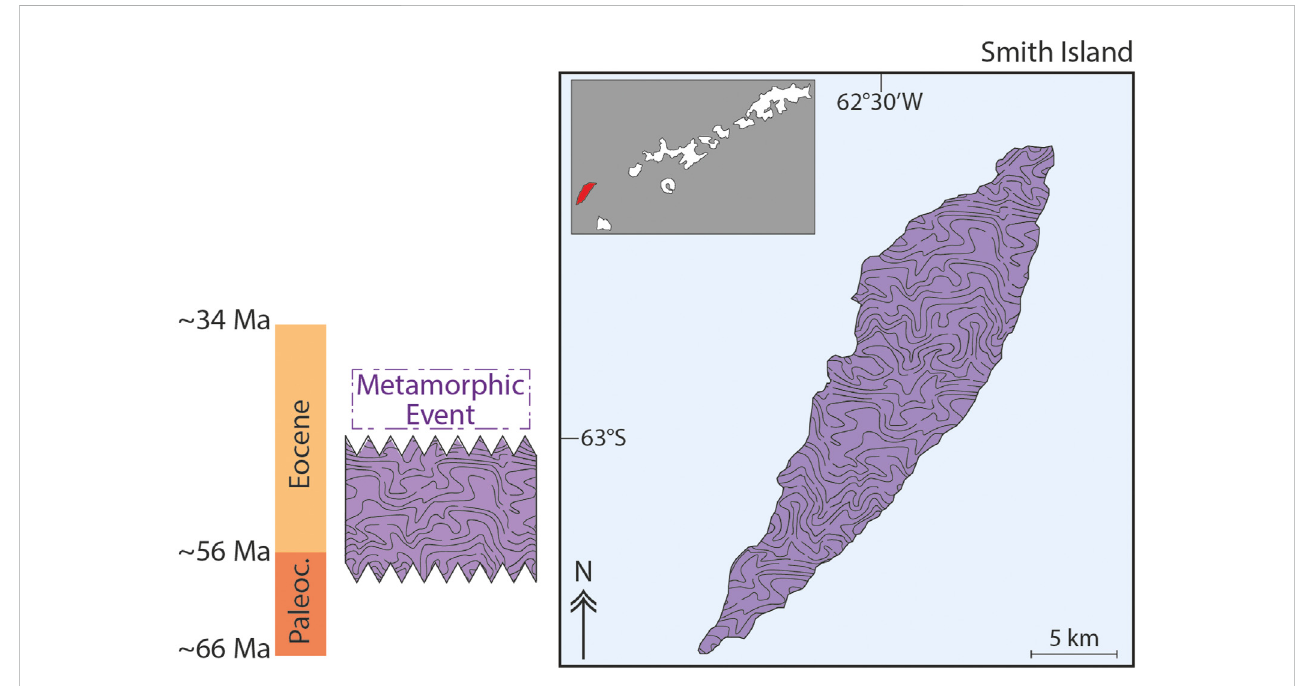
FIGURE 4 Revised geological map of Smith Island, modi fi ed from Grunow et al. (1992).